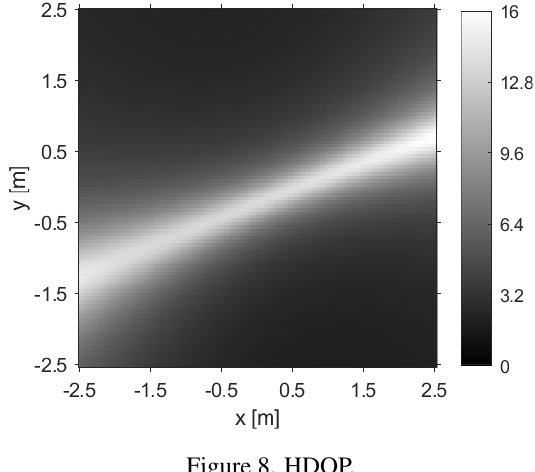
Figure 5. Errors on the UWB position estimates in the Adapt.EKF1 case.